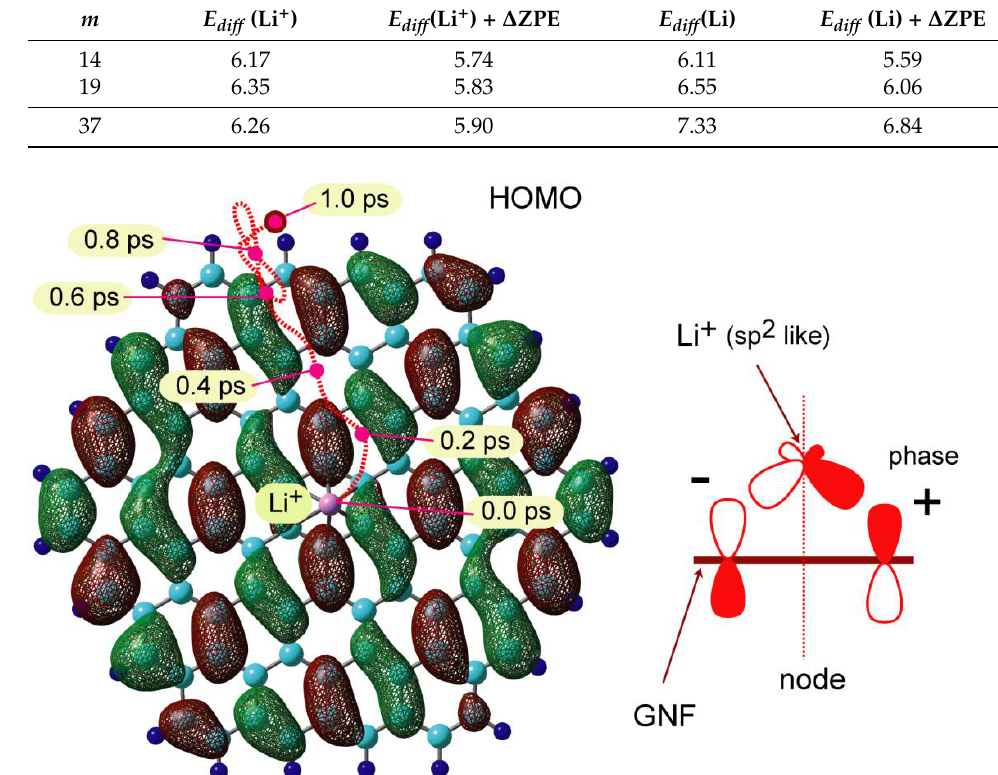
Table 2. The diffusion barriers ( E diff in kcal/mol) of the Li species (Li + ions and Li atoms) on GNFs of several sizes, (GNF( m ), m = 14, 19, and 37), where m is the number of benzene rings comprising the GNF. The E diff + ΔZPE values (in kcal/mol) are the diffusion barrier values after the zero-point en- ergy (ZPE) corrections. All calculations were carried out at the CAM-B3LYP/6-311G(d,p) level of theory.